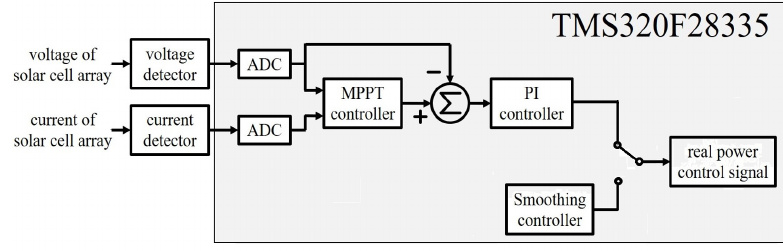
Figure 6. Control block for real power control signal.